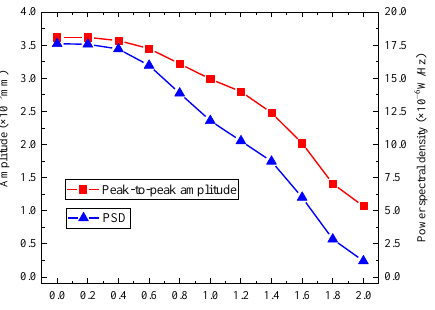
Figure 30. The influence of defect depth on the received signal (transmitted wave). The influence of defect width on reflected and transmitted signals of surface waves is shown in Figures 31 and 32, respectively. The red curve represents the peak-to-peak amplitude, corresponding to the left Y axis, and the blue curve represents the maximum of the PSD function, corresponding to the right Y axis. Similar to the defect depth characterization curve, whether it was the peak-to-peak amplitude or the maximum of the PSD function, the characteristics of the reflected signal gradually increased with the increase of the defect width; the characteristics of the transmitted signal gradually decreased with the increase of the defect width. Moreover, since the PSD function was less interfered with by the overlap and transformation of wave packets and noise, the characterization curve was smoother compared with the peak-to-peak amplitude, and the difference in signal characteristics was greater under the same defect width difference, which means it is more suitable for quantitative detection of groove-shaped defects. Unlike the influence trend of defect depth, the influence of defect width on both reflected and transmitted signals was small. This is mainly because the most important factor affecting the received signal characteristics is whether there was a defect or not, and when there was already a defect, the influence of defect width was less obvious.